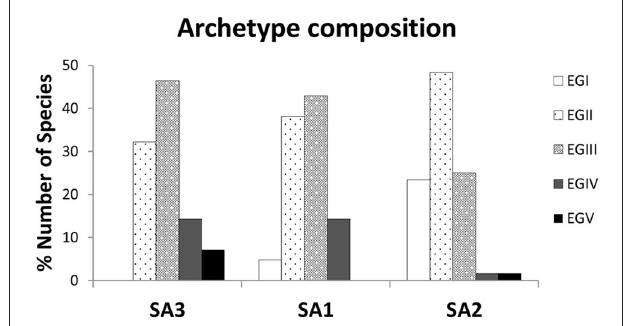
FIGURE 2 | Composition of the 3 Species Archetypes in terms of percentage of species belonging to each ecological tolerance group (sensitivity scores assigned according to the Turkish national database). Definition of species tolerance groups: EGI, disturbance sensitive; EGII, disturbance indifferent; EGIII, disturbance tolerant; EGIV, second-order opportunist; EGV, first order